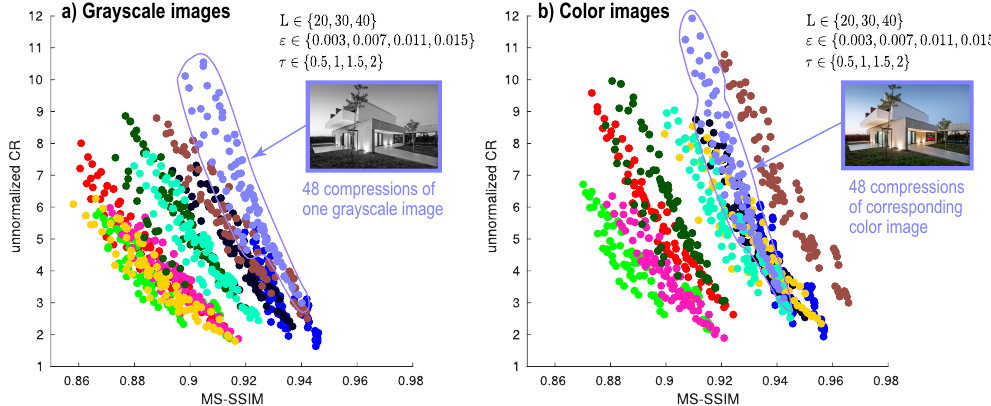
Figure 7. Trade-off between MS-SSIM and CR on 10 grayscale house images ( a ) and their corresponding color versions ( b ). The outlines show the compressions of a single image for 48 parameter combinations.